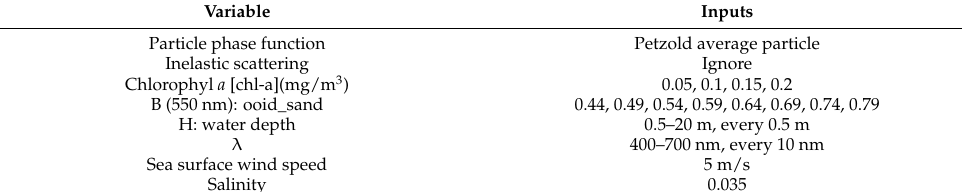
Table A1. Environmental inputs used in the Hydrolight simulations.